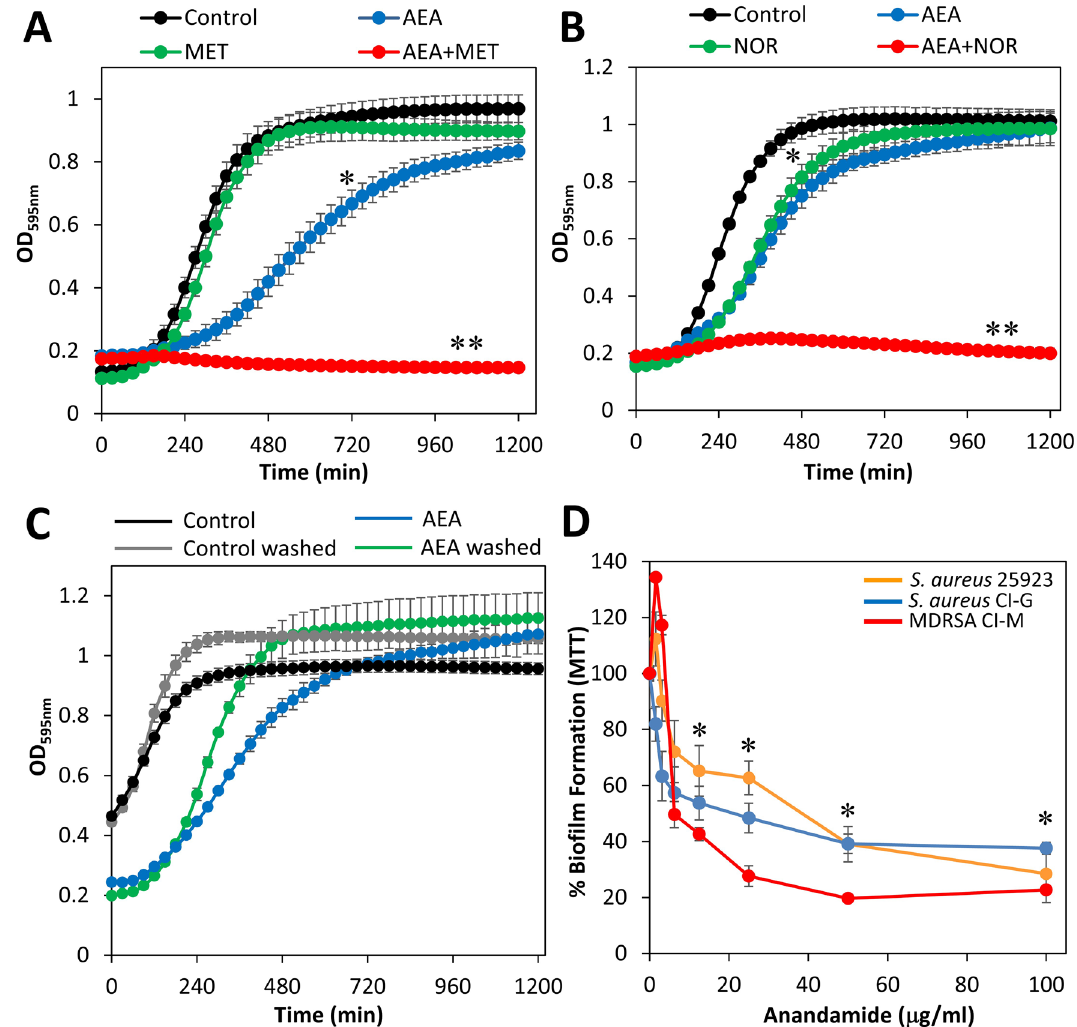
Figure 3. ( A ) A kinetic study of the planktonic growth of MDRSA CI-M in the absence or presence of 50 μg/ ml AEA and/or 50 μg/ml methicillin for 20 h. ( B ) A kinetic study of the planktonic growth of MDRSA CI-M in the absence or presence of 50 μg/ml AEA and/or 50 μg/ml norfloxacin for 20 h. ( C ) MDRSA CI-M at an OD of 0.1 was incubated in the presence of 50 μg/ml AEA for 4 h, then the AEA medium from half of the culture was replaced with fresh growth medium (washed), while the other half of the culture remained with AEA. The same procedure was done for control bacteria. This was followed by a kinetic study of the planktonic growth for 20 h. ( D ) The effect of AEA on the biofilm formation by the three S. aureus strains MSSA 25923, MSSA CI-G and MDRSA CI-M. After a 24 h incubation of the bacteria with increasing concentration of AEA, the metabolic activity of the formed biofilms was measured using the MTT assay. *p < 0.05; **p <